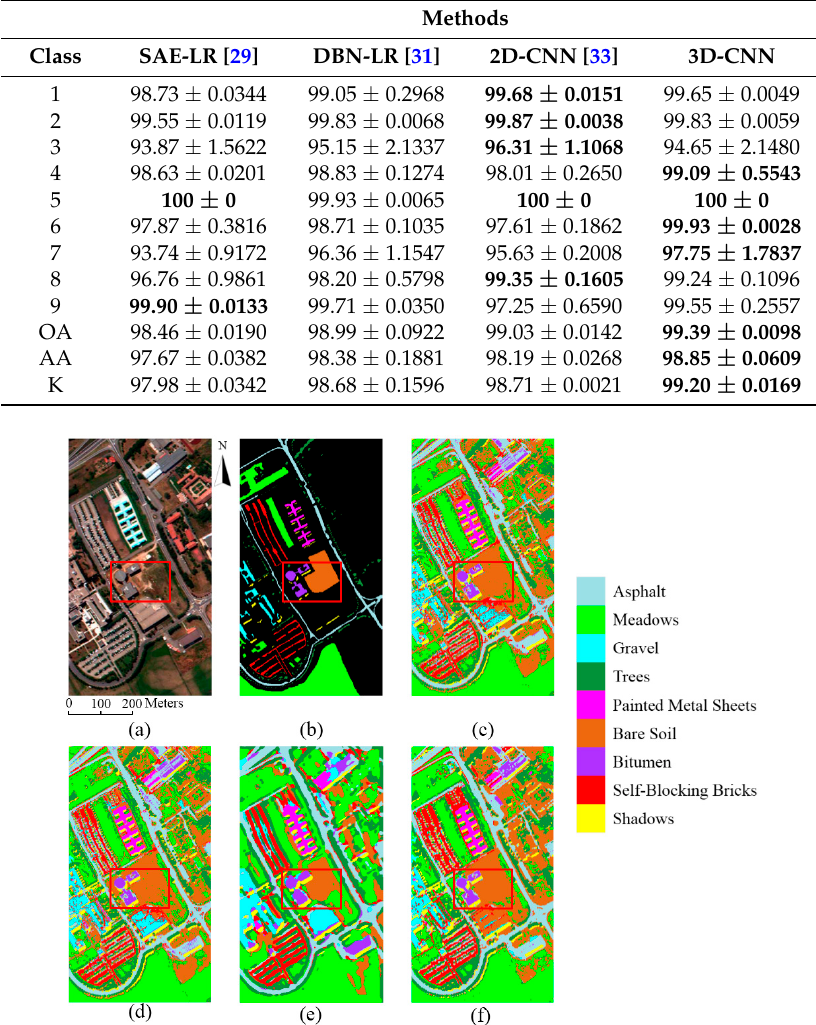
Table 5. Classification results (%) of Pavia University scene. AA: average accuracy; OA: overall accuracy;